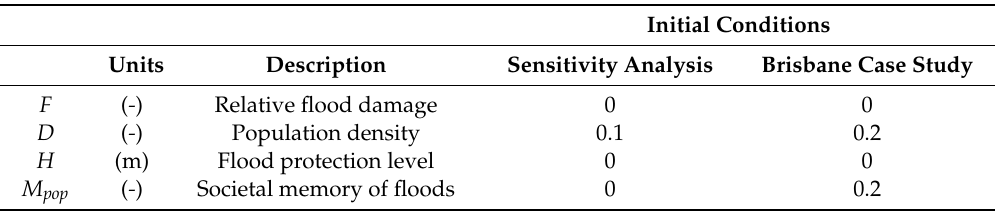
Table 3. Time-varying variables of the flooding module and initial conditions used in the sensitivity analysis and the Brisbane case study.